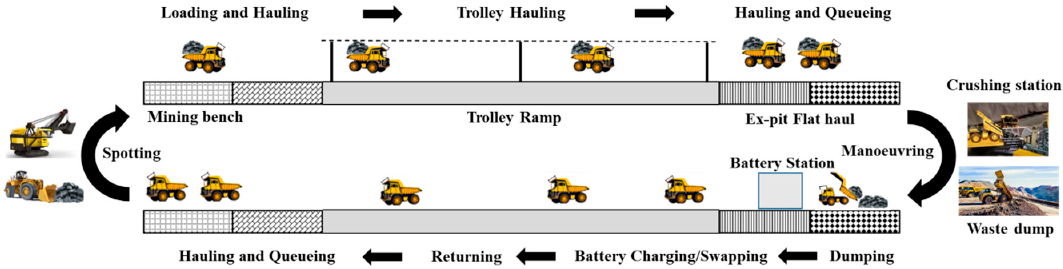
Figure 15. A schematic of stationary charging BT systems operational process.